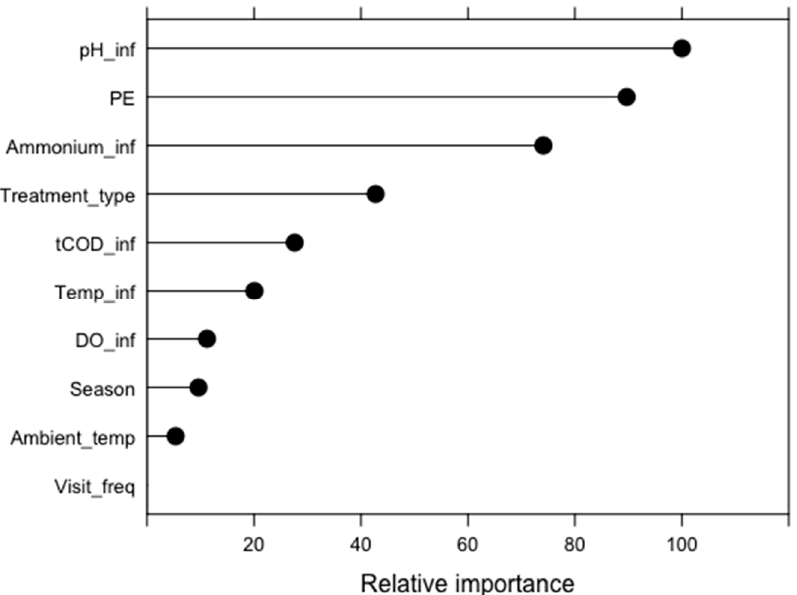
Figure 4. Relative importance of predictors as determined by random forest. pH_inf is the pH of the influent wastewater; Ammonium_inf is the concentration of ammonia in the influent wastewater; PE is the population equivalence; Treatment_type is the treatment plant technology; Temp_inf is the temperature of the influent wastewater; tCOD_inf is the concentration (mg/L) of tCOD in the influent wastewater; Visit_freq is the number of times an operator visits the site per week; DO_inf is the concentration of dissolved oxygen in the influent wastewater; Season is UK season; Ambient_temp is the atmospheric temperature at the time of sample